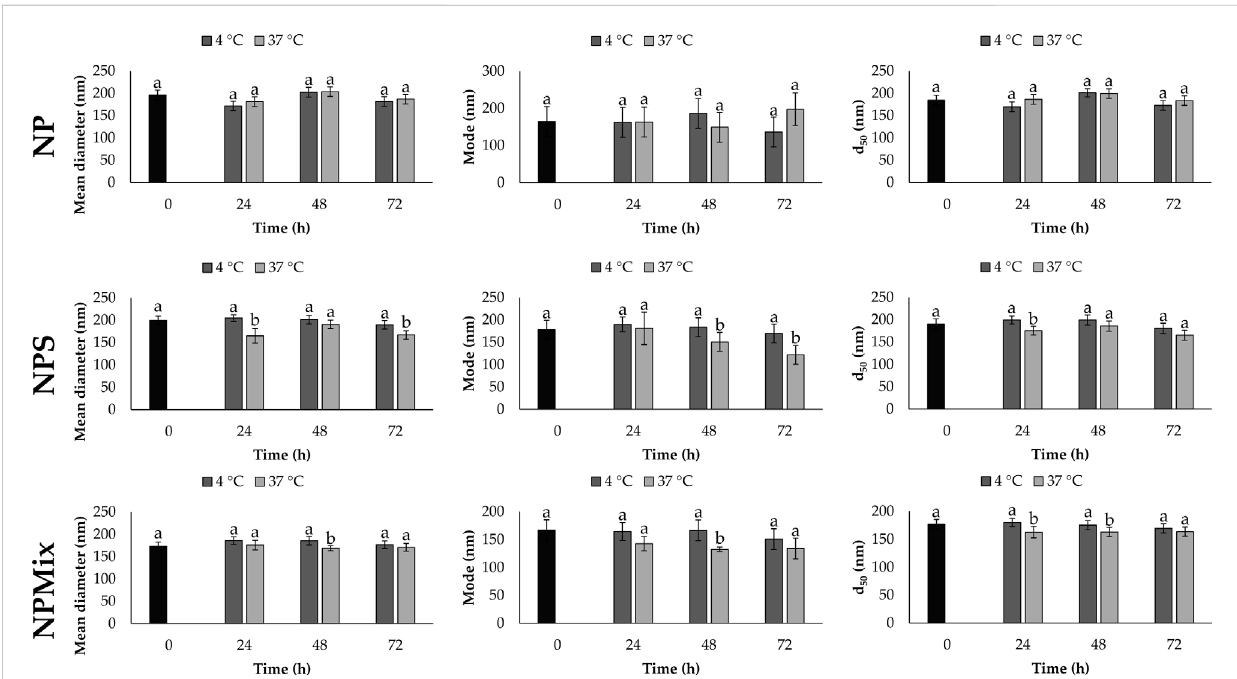
FIGURE 2 Meandiameter,modeandd 50 forNP,NPSandNPMixformulationsstoredatfouror37 ° Cfor24,48and72 h.Dataarereportedasmeanvalue±LSD, Multifactor ANOVA, n = 15 for each formulation. Letters (a and b) are used to compare the means of different groups. If the letters are different, there is a statistically signi fi cant difference between the means ( p < 0.05); if the letters are the same, there is no statistically signi fi cant difference between the means ( p >